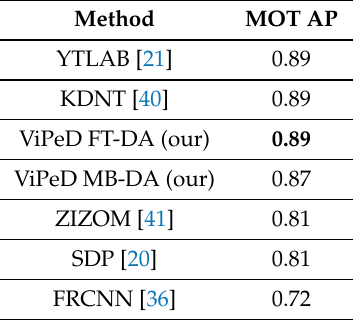
Table 2. Evaluation of the two Domain Adaptation (DA) techniques on the MOT17Det dataset. one. Results are evaluated using the MOT mean average precision (mAP). We report in bold the best